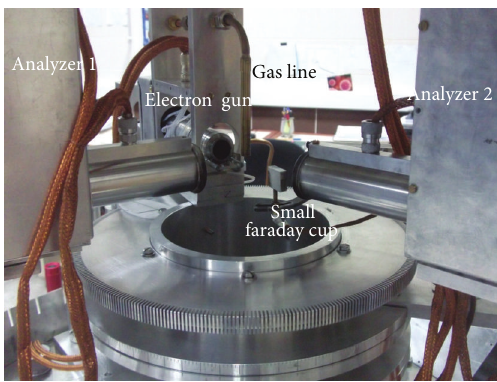
Figure 2: A photograph of the electron spectrometer showing the electron gun, the hemispherical analyzers, the Faraday cup, and the gas line. The electron spectrometer is located in the vacuum